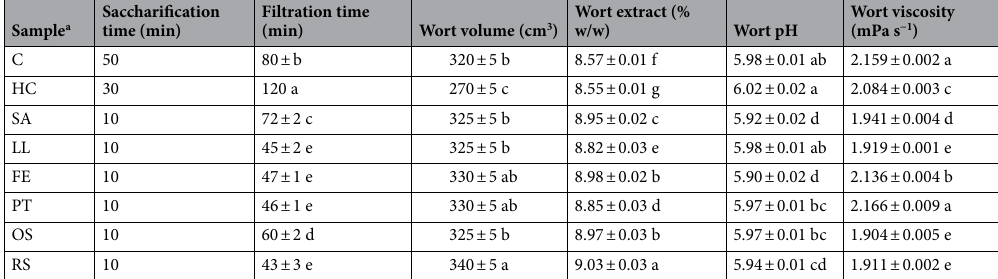
Table 1. Technological properties of winter wheat malts. a Data are shown as means ± standard deviation (n = 2 in case of saccharification time, filtration time, wort volume; n = 6 in case of wort pH and wort viscosity). Different letters indicate homogenous groups analysed with the Tukey test (α = 0.05). Abbreviations are as follows: C malt produced from wheat grains grown without addition of seed meals or herbicides, HC malt produced from wheat grains grown without addition of seed meals, cultivated with herbicide treatment; FE malt produced from wheat grains grown with addition of seed meal from Fagopyrum esculentum Moench., SA malt produced from wheat grains grown with addition of seed meal from Sinapis alba L., PT malt produced from wheat grains grown with addition of seed meal from Phacelia tanacetifolia Benth., LL malt produced from wheat grains grown with addition of seed meal from Lupinus luteus L., RS malt produced from wheat grains grown with addition of seed meal from Raphanus sativus L. var oleiformis Pers., OS malt produced from wheat grains grown with addition of seed meal from Ornithopus sativus